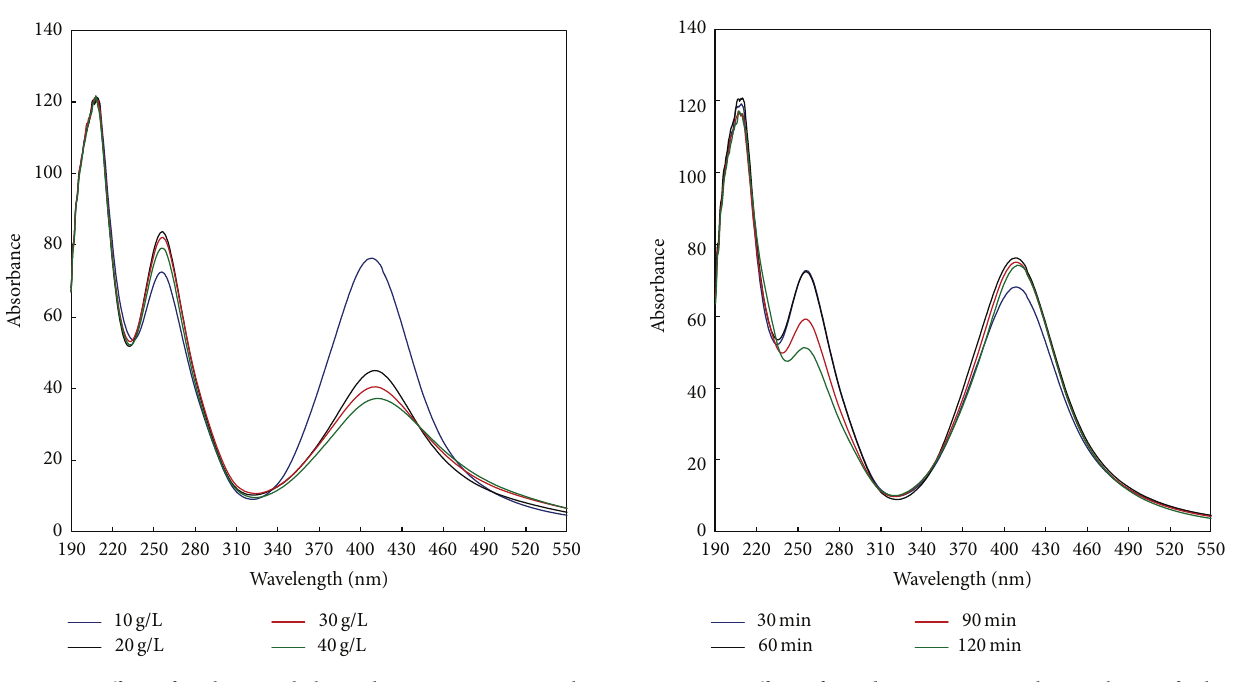
Figure 3: Effect of carboxymethyl starch concentration on the synthesis of silver nanoparticles [CMS], 10–40 g/L; [PI], 1g/L; [AgNO 3 ], 1g/L; temp., 30 ∘ C; time, 60 min.; M:L ratio, 1: 20; pH, 7.